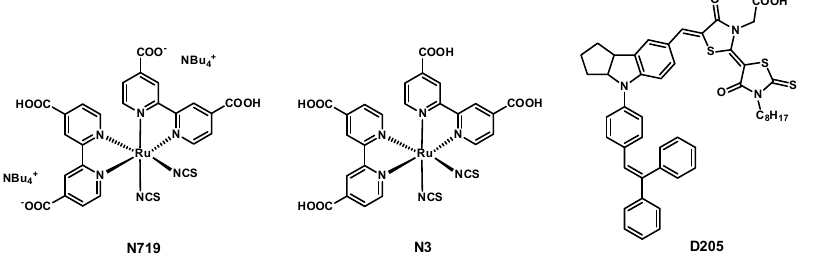
Figure 2. Structure of dyes N719 , N3, and D205 .